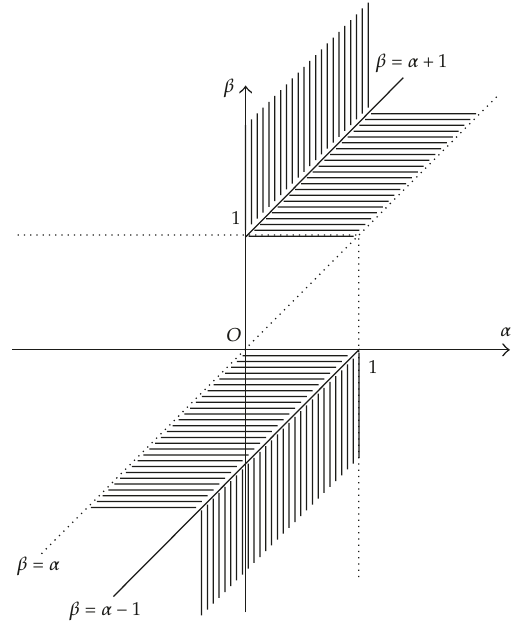
Figure 2: (cid:3) α,β (cid:5) -domain where q α,β (cid:3) t (cid:5) decreases on (cid:3) −∞ , ∞ (cid:5)